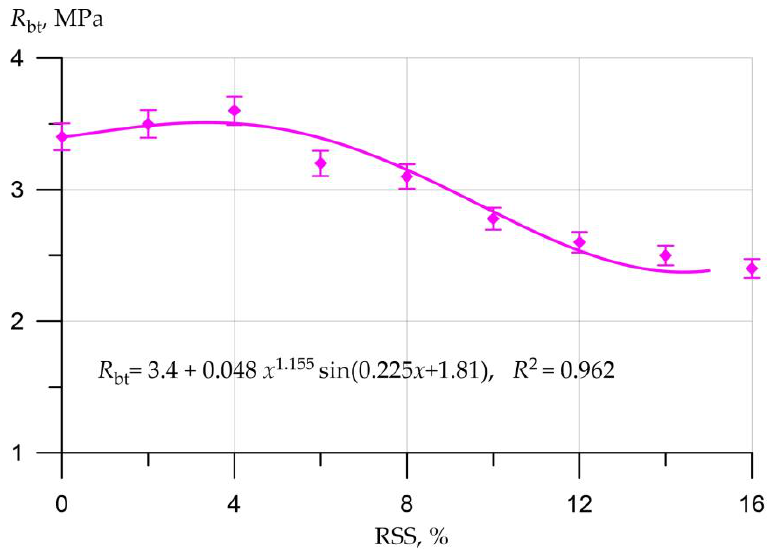
Figure 6. Consequences of investigational studies of the influence of local replacement of CA with RT seed shells on TS in twisting R btb .